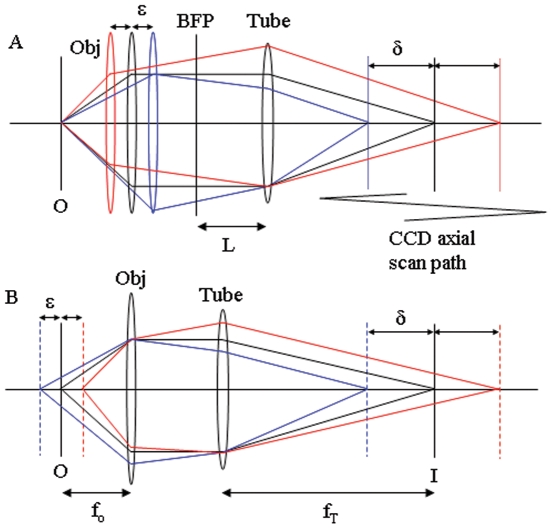
Ray diagram for object and image axial positions.Object displacement ε from the objective effective focal point at O gives image displacement δ from the tube lens focal point at I. The CCD axial scan path shows camera translation in image space. BFP is the back focal plane of the objective and L is the tube length. The Tube lens has focal length fT. Panel A shows point source repositioning relative to a fixed microscope stage due to translation of the objective (Obj) with focal length fO. Panel B shows an equivalent point source repositioning due to a translating microscope stage.